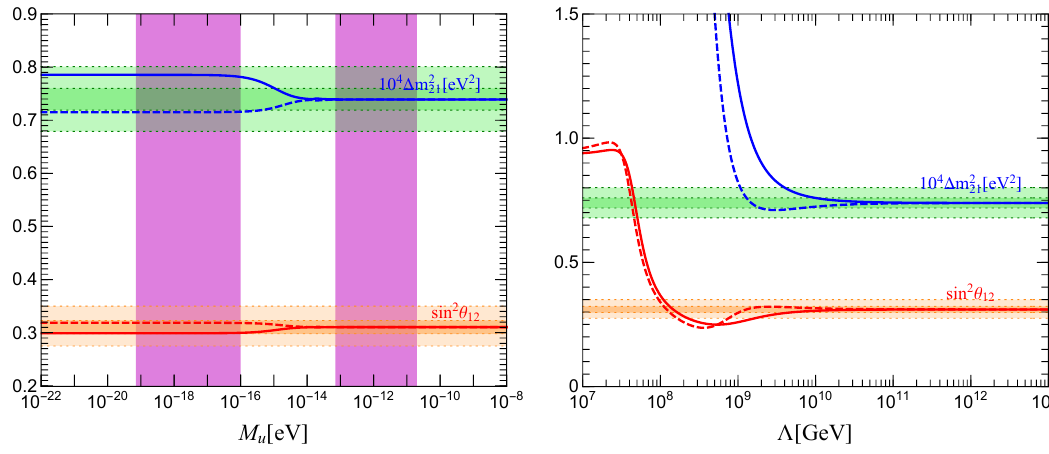
Figure 4 . (cid:1) m 2 and sin 2 (cid:18) 12 versus M u for (cid:3) = 5 (cid:2) 10 9 GeV (left panel) and versus (cid:3) for 21 M u = 10 (cid:0) 22 eV (right panel). We set h = 1 and the angle (cid:18) has been tuned to suppress the scalar- electron coupling below the experimental bound. Solid(dashed) line for plus(minus) sign in eq. (6.7), respectively. The darker(lighter) green and orange bands show the present 1 (cid:27) (3 (cid:27) ) allowed region from [39, 40]. The combination n 0 F ( M (cid:11) R ) is the one of eq. (2.9), with n e ( r ) from refs. [14, 15]. e The vertical bands in purple are excluded from black hole